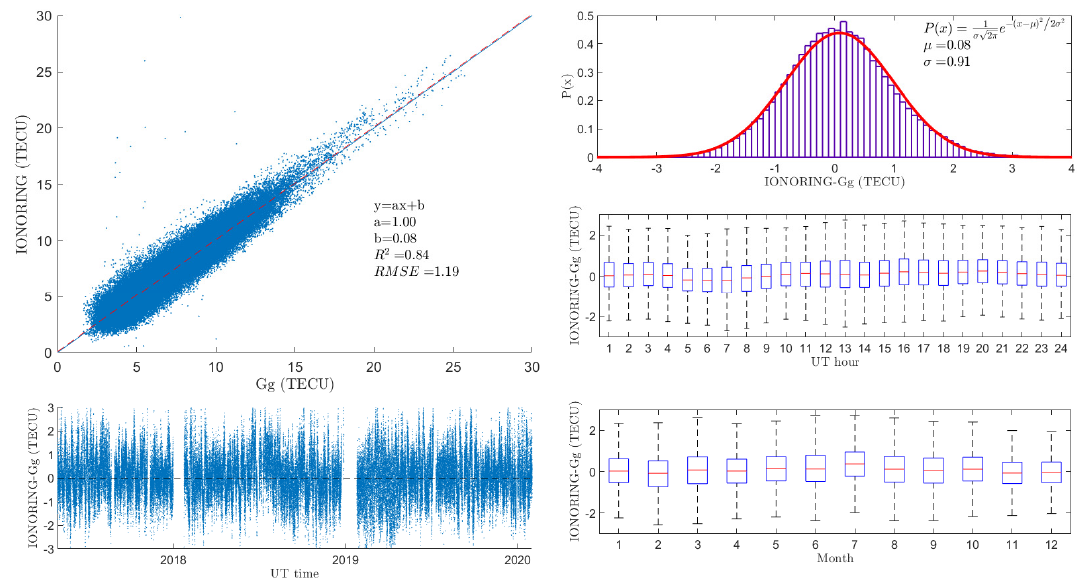
Figure 2. Scatter plot of vTEC from IONORING over mter against vTEC directly measured by mter and calibrated with Gg technique. The linear fit (red-dashed line) and its features (in the textbox) are reported, while the blue line indicates the bisector (panel a ). Time profile of the difference between IONORING and Gg vTEC (panel b ). Probability distribution of the difference between IONORING and Gg vTEC and the corresponding Gaussian fit (red), whose expression and parameters are also reported in the textbox (panel c ). Boxplots of the hourly (panel d ) and monthly (panel e ) differences between IONORING and Gg vTEC. In the boxplots, the red line indicates the median, and the bottom and top edges of the box indicate the 25th and 75th percentiles, respectively, while the range marked by the dashed lines indicates the extrema.